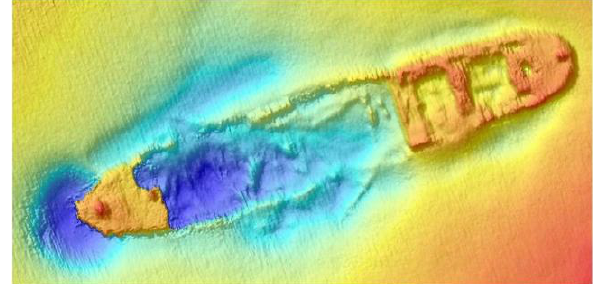
Figure 9: Río Miera Digital Elevation Model from multibean data.